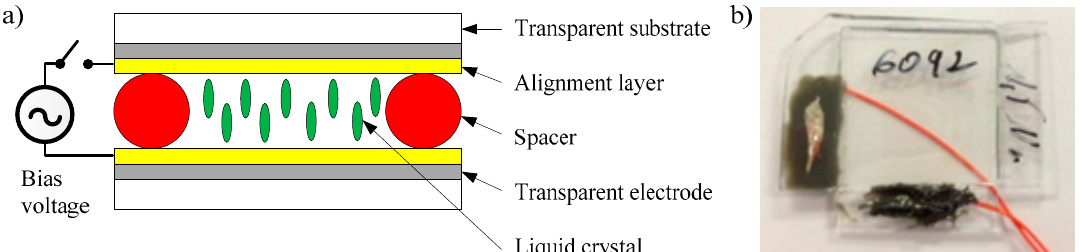
Figure 2. ( a ) Schematic illustration of homeotropic alignment in a nematic liquid crystal cell with no applied external voltage (V BIAS = 0 V). ( b ) Picture of an experimental NLC cell used in the wireless temperature sensor.